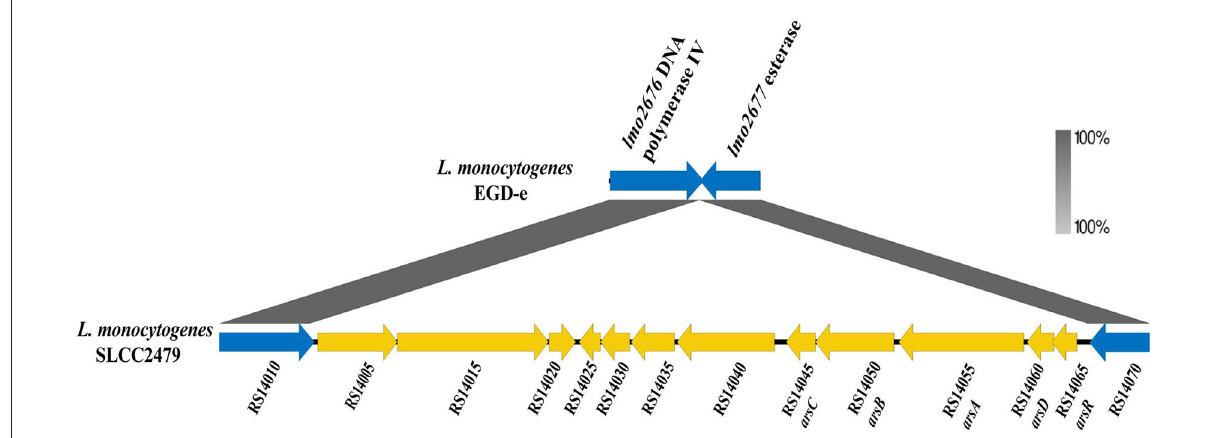
FIGURE3 Genomic components of the Tn554-like element of strain SLCC2479. The genes within Tn554-like elements are shown in yellow, and flanked genes of the Tn554-like element in strain EGD-e are shown by blue arrows. The annotation and locus tag of the genes refer to NCBI GenBank